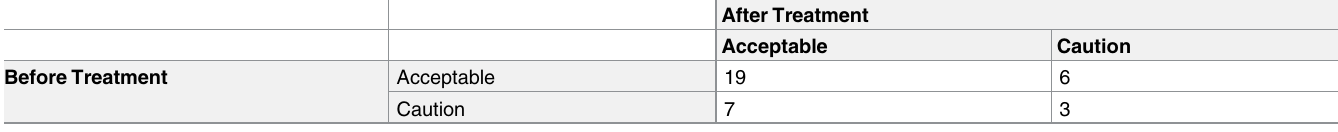
Table 5. F-index category distributions when the BASC-2 scale was administered before and after praziquantel mass treatment a .